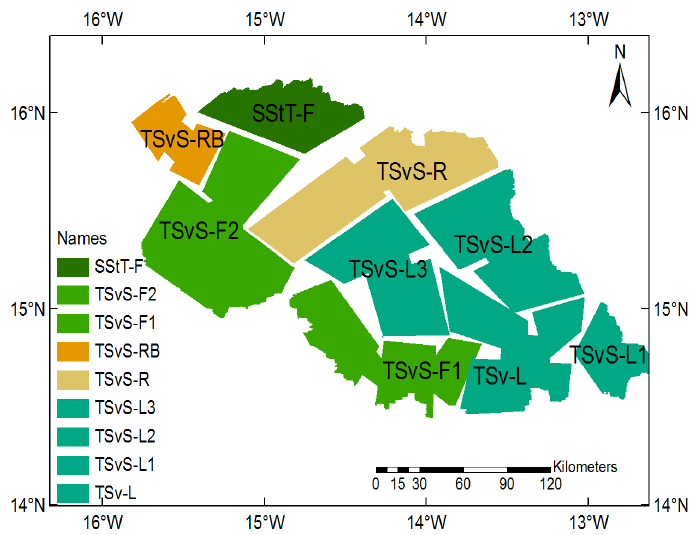
Figure 2. Vegetation-Soil Zones (VSZ) map obtained from the superposition of the land-cover and soil-type maps, the heterogeneous transition zones were masked. The legend items are spelled out in Table 3.